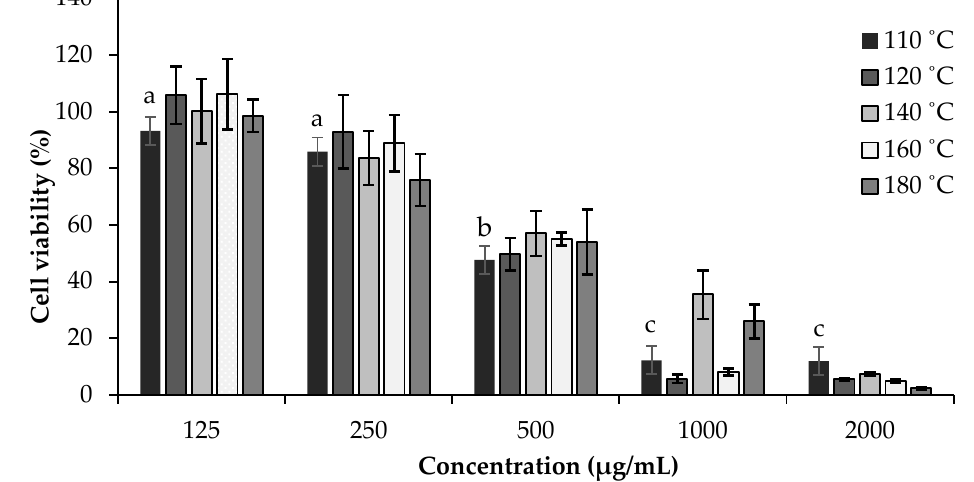
Figure 2. Effects of C. sativa shells SWE extracts on the viability of TR146 cells at concentrations range of 125–2000 µ g/mL, measured by MTT assay, at 24 h. Values are expressed as mean ± standard deviation ( n = 3). Different letters indicate significant differences between concentrations of the same sample ( p < 0.005), according to Tukey’s HSD test.